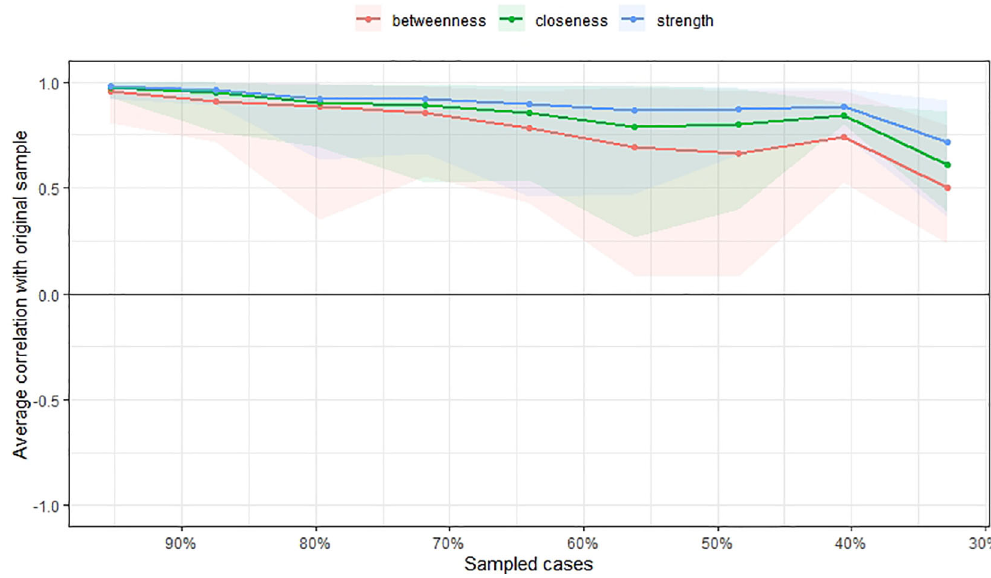
Figure 3. Stability of central indices.